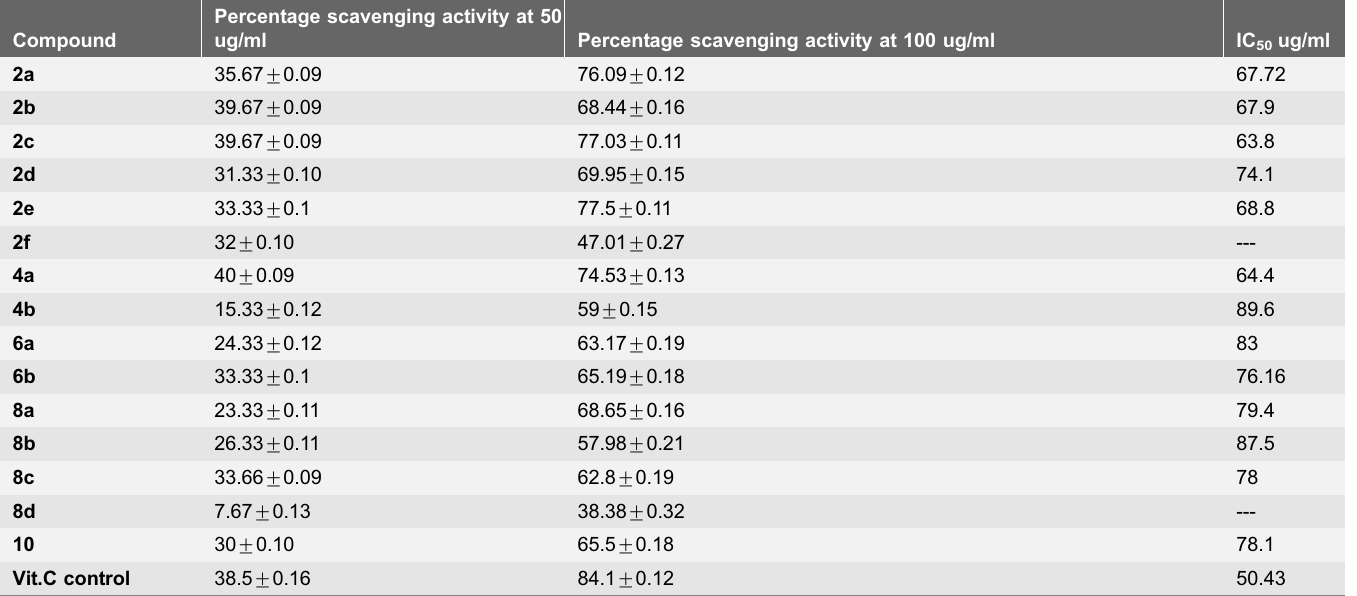
Table 7. Nitric oxide scavenging activity.